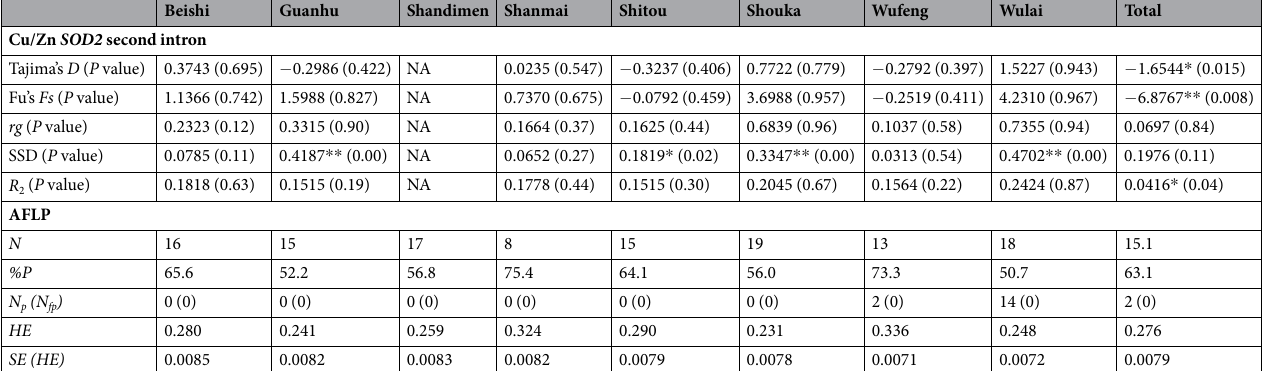
Table 2. Neutrality test statistics and mismatch analysis based on the second intron sequences of Cu/Zn SOD2 and summary of genetic diversity based on 521 amplified fragment length polymorphic loci of eight populations of Musa basjoo var. formosana . * P < 0.05, ** P < 0.01 N , number of samples; %P , percent of polymorphic loci at the 5% level; H E , Nei’s gene